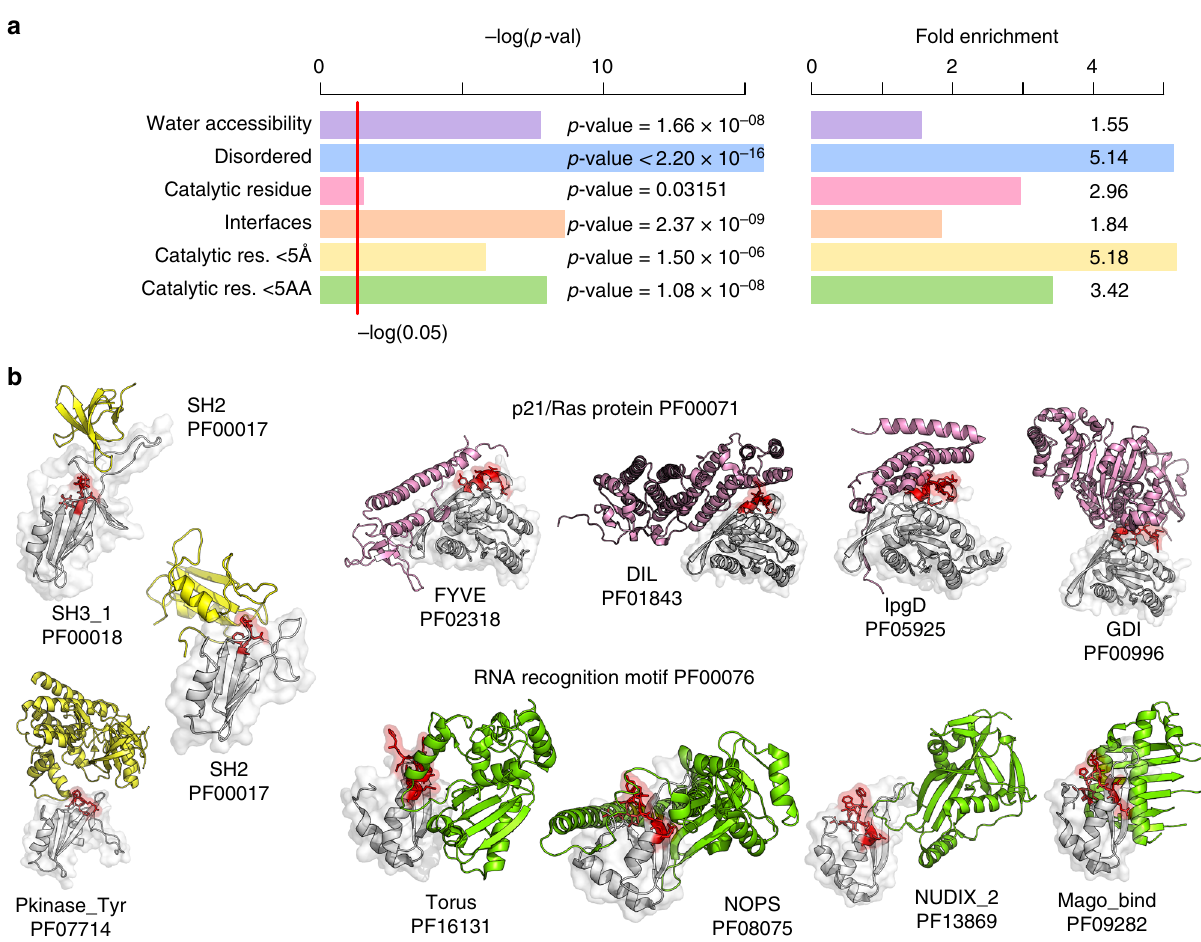
Fig. 3 Structural features of phosphorylation hotspots. a Enrichment over random of structural features comparing hotspots with other residues within the same domains. The tested features include water accessibility — residues with >20% RSA; protein disorder as predicted by DISOPRED; catalytic residues; residues within 5 amino-acid distance to a catalytic residue; residues within 5 Å of a catalytic residue; residues at an interface based on 3DID. For each feature we report the − log( p -value), p -value calculated using Fisher ’ s exact test. b Examples of hotspot regions at interfaces where the hotspot region (red) from a domain (gray) has been observed contacting many other types of domains (other colors) in empirical